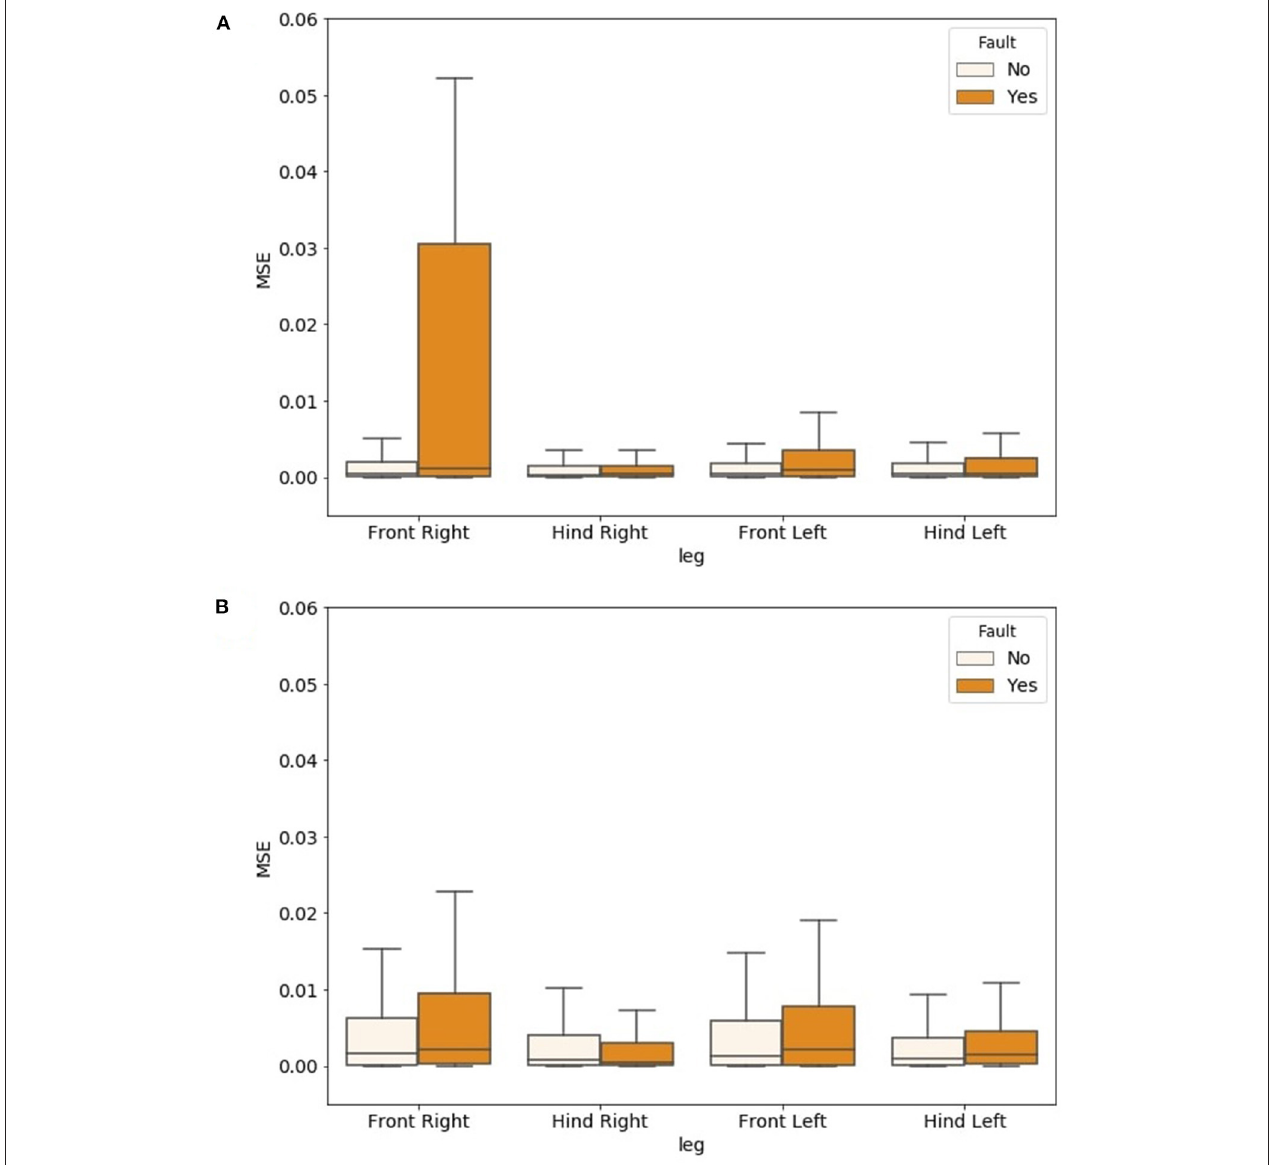
FIGURE 6 | Comparison of prediction errors between samples with and without faults for the four GRF signals predicted as output of the ESN. The model was trained using only data from normal working conditions (A) , and using data in which artificial faults were introduced in all the legs during the training phase (B)